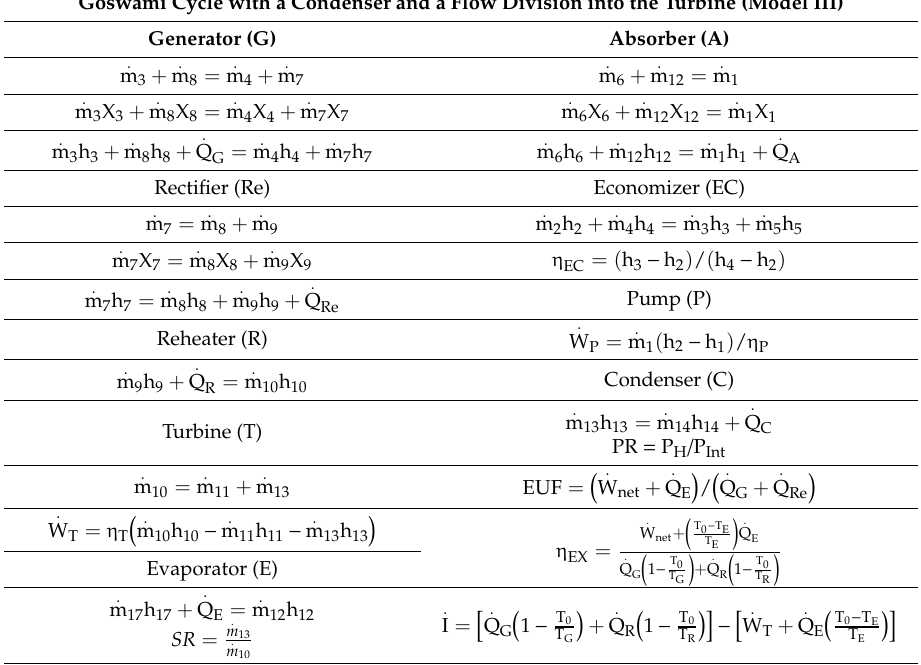
Table 3. Main equations for the Goswami cycle with flow extraction in the